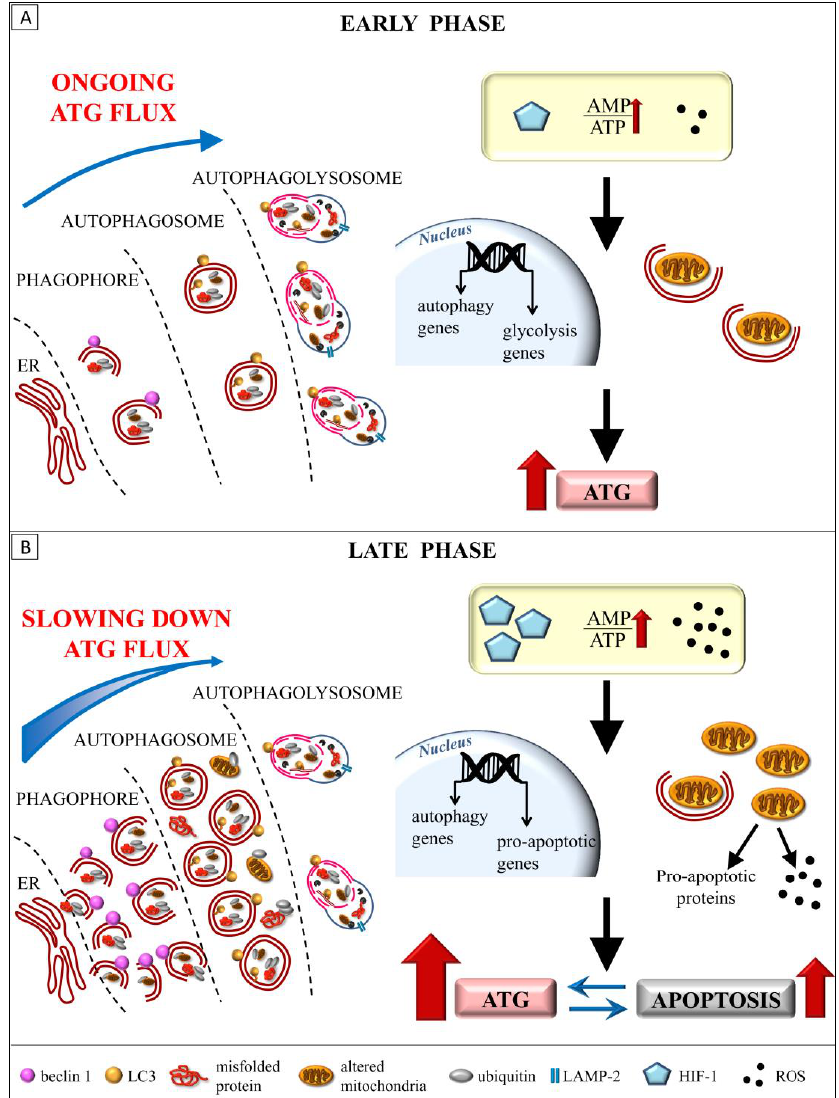
Figure 4. A dynamic model for the protective role of ATG in CBH. ( A ) The early phase of CBH is characterized by a sudden increase of the ATG activation. In this phase, the O 2 and nutrients deprivation rapidly induce ATG, which is effective in the removal of altered cell components. Oxidative stress damages mitochondria, which are suddenly cleared by mitophagy. In this early phase of CBH, the ATG flux is normally ongoing and the ATG activation is key in delaying the cell death. ( B ) In the late phase of CBH, the protracted hypoxia, the severe energy deprivation, along with a further increase in the ROS levels, seriously worsen the cell functions. In these conditions, ATG further increased, but the broad cargoes overwhelm the ATG capacity, leading to a defective cell clearance. In particular, damaged mitochondria accumulate within the cytosol and become by themselves a source of additional ROS. Moreover, altered mitochondria release cytochrome c and other pro-apoptotic proteins. On the other hand, in this late phase of CBH, apoptosis is induced by a variety of stimuli. In particular, the apoptosis is triggered by the severe hypoxia, associated with mitochondrial damage and oxidative DNA injury. In this condition, a concomitant strong increase of both the ATG and apoptosis occurs. Moreover, the apoptosis and ATG are strictly interconnected and reciprocally regulated by several mechanisms. Therefore, the late CBH features as accumulation of ATG vacuoles, because of the relented ATG flux and increased apoptotic cell death. Red arrow: increased activity/levels, Blue straight arrow: modulatory effect, Blue curved arrow: intensity of ATG